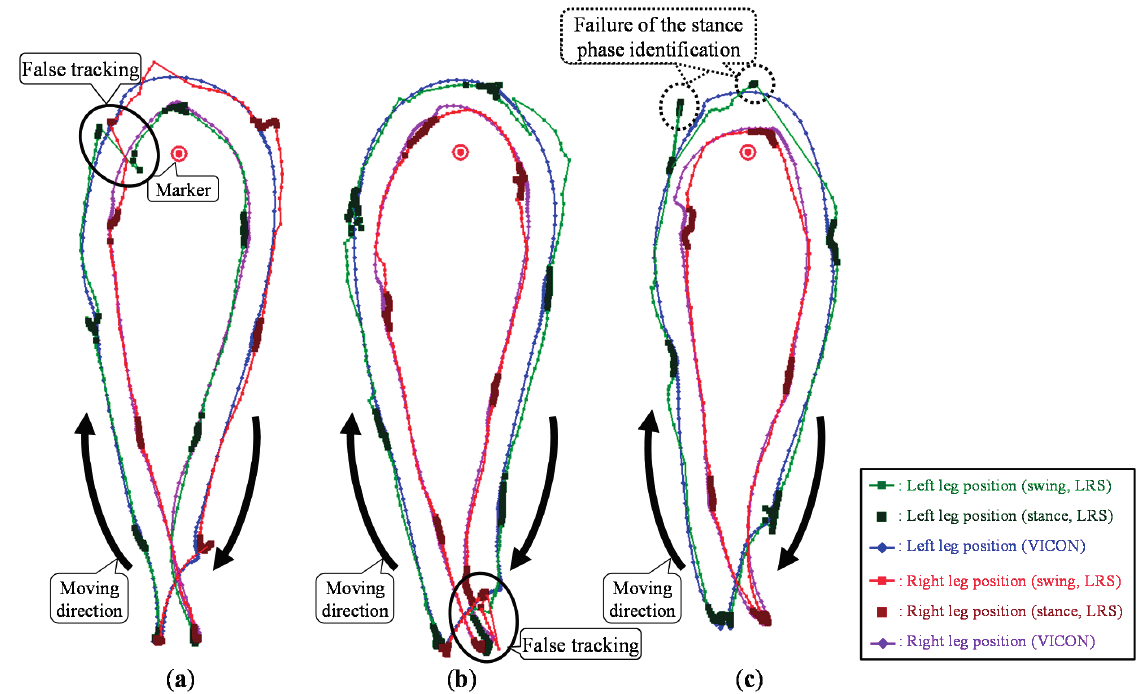
Figure 11. Leg tracking results of false tracking and the failure of the stance phase identification. ( a ) False tracking via switching of the left and right legs during turning motion with Method 1. ( b ) False tracking during walking back to the chair with Method 2 ( c ) Failure of the stance phase identification during the turning motion with Method